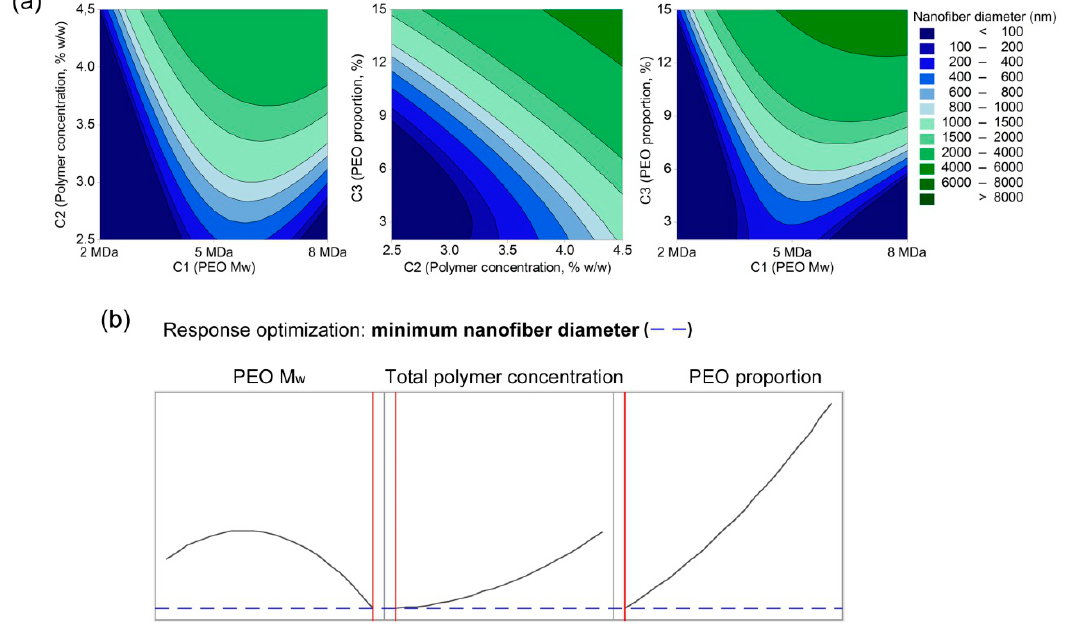
Figure 8. ( a ) contour plots of the resulting nanofiber diameter as a function of total polymer concentration and PEO M w (left), PEO proportion and total polymer concentration (middle), and PEO proportion and PEO M w (right); ( b ) response optimization for the resulting nanofiber diameter as a function of PEO M w , total polymer concentration, and PEO proportion.